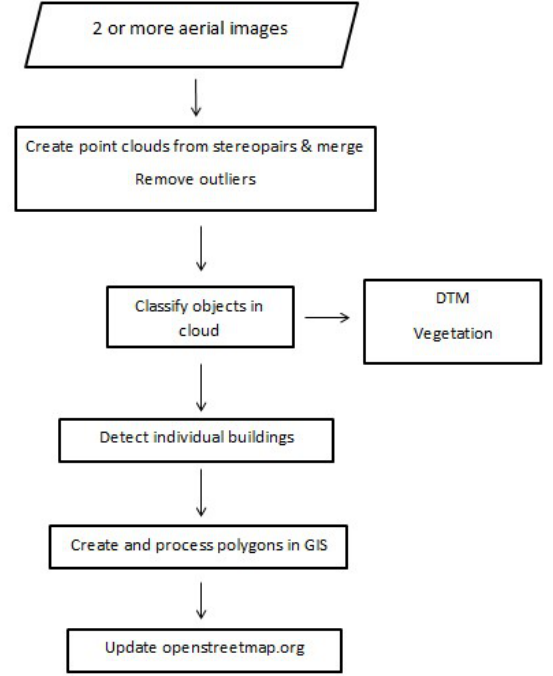
Figure 1: Main stages of the